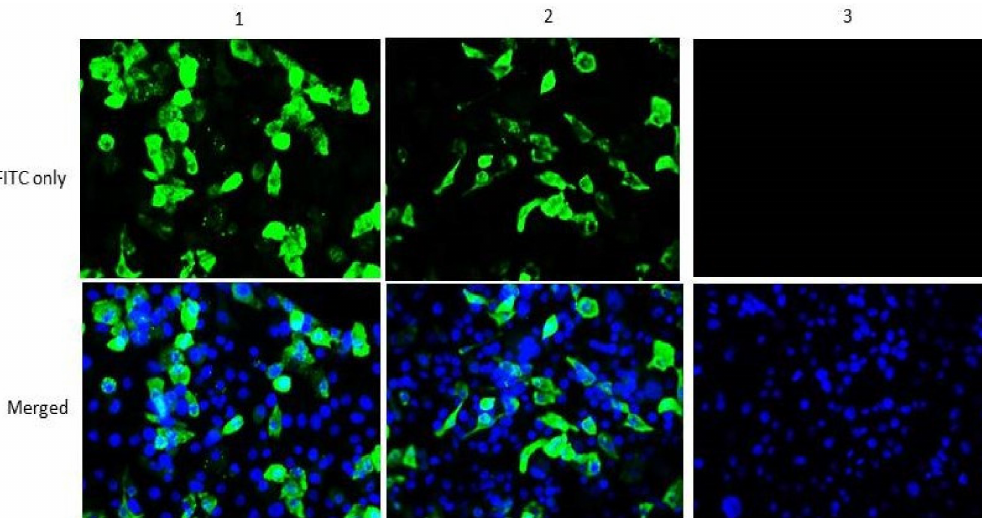
Figure 1. Immunofluorescence based detection of nucleoprotein (NP) and phosphoprotein (P) encoded by the helper plasmids. Actively dividing Baby hamster kidney (BHK-21) cells at 80% confluence were transfected with ( 1 ) pCIneo-NP. ( 2 ) pCIneo-P and ( 3 ) empty pCIneo plasmid (negative control). At 72 h post-transfection, the cells were fixed, permeabilized, and stained with chicken polyclonal IgY against Newcastle Disease Virus (NDV) followed by goat anti-chicken antibody conjugated with FITC. The cells were counter-stained with DAPI. Green and blue colors respectively represent FITC and DAPI. Images were captured using Zenlite fluorescence imaging software at X